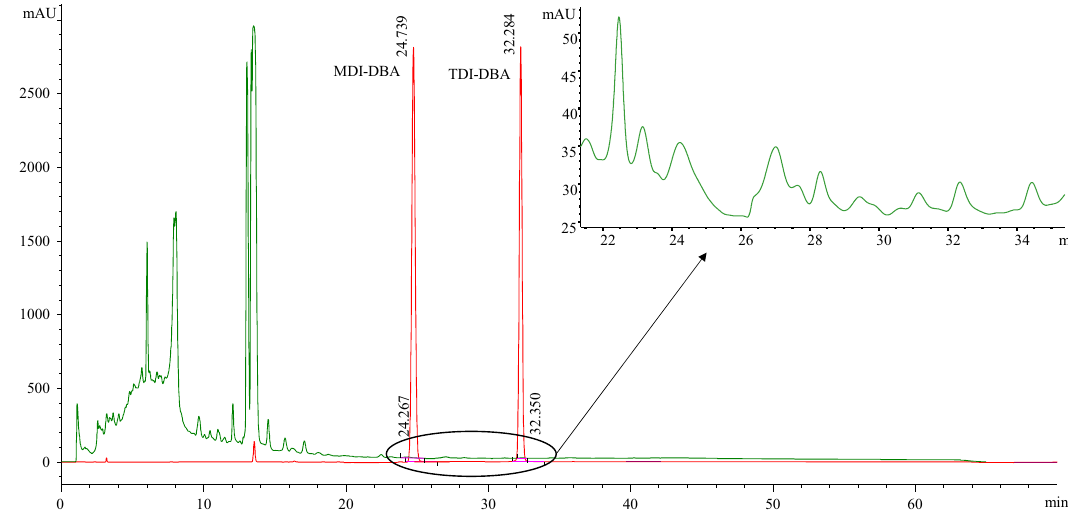
Figure 3. Overlay of a standard mixture (red line) and a real sample (green line) chromatograms.